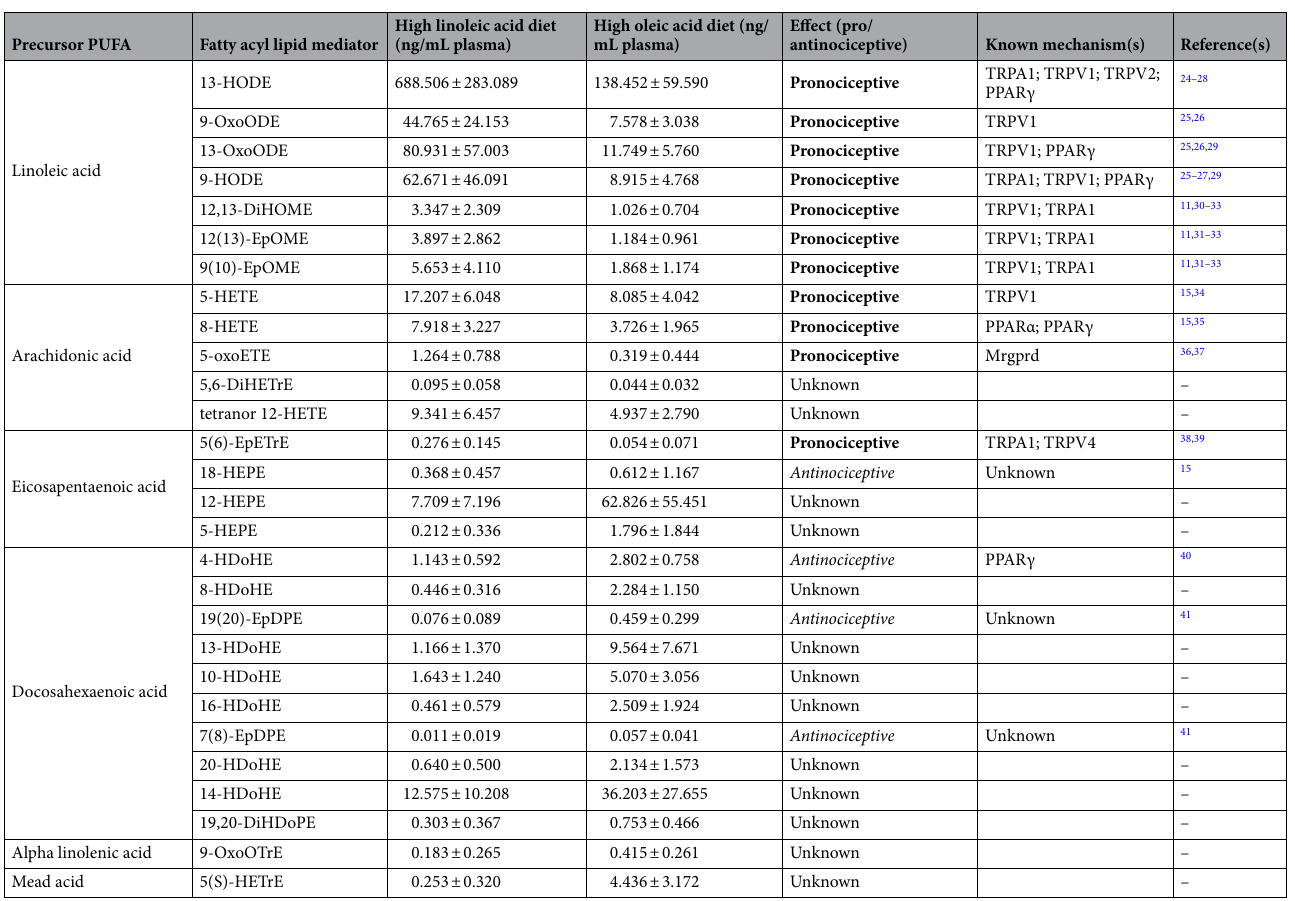
Table 1. Lipid mediators significantly altered by dietary linoleic acid content. LMs with known pronociceptive activity are highlighted in bold and those with known antinociceptive activity are highlighted in italics. PUFA polyunsaturated fatty acid; 13-HODE (9Z,11E)-13-hydroxyoctadeca-9,11-dienoic acid; 9-OxoODE (10E,12Z)-9-oxooctadeca-10,12-dienoic acid; 13-OxoODE (9E,11E)-13-oxooctadeca-9,11-dienoic